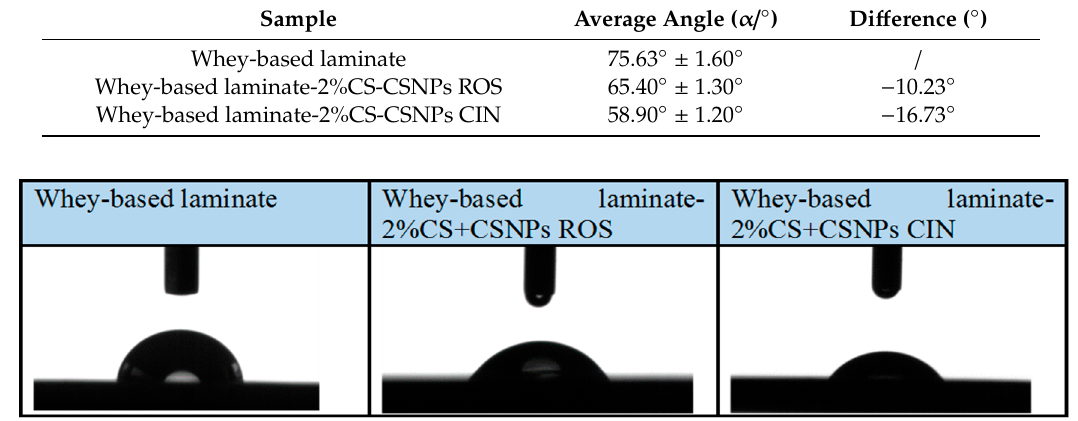
Table 1. Contact angles of whey-based laminates.